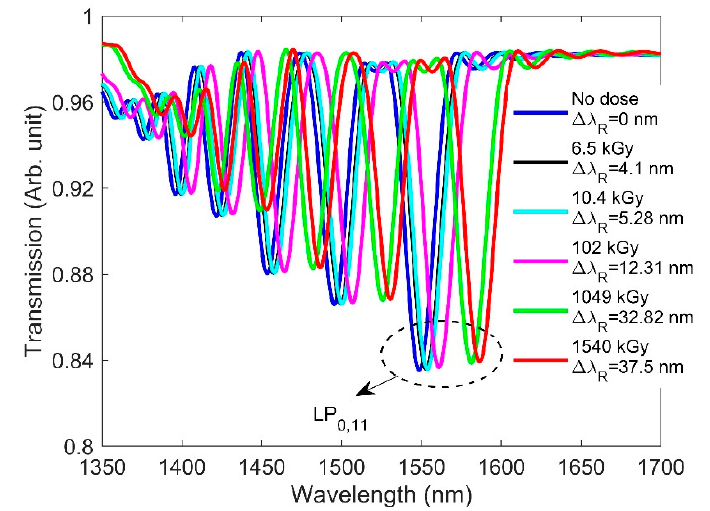
Figure 7. RIC effects on the transmission spectrum of the designed LPG along with the resonance wavelength shift ( ∆ λ R ) for the LP 0,11 cladding mode when the dose is increased from 0 to 1540 kGy.